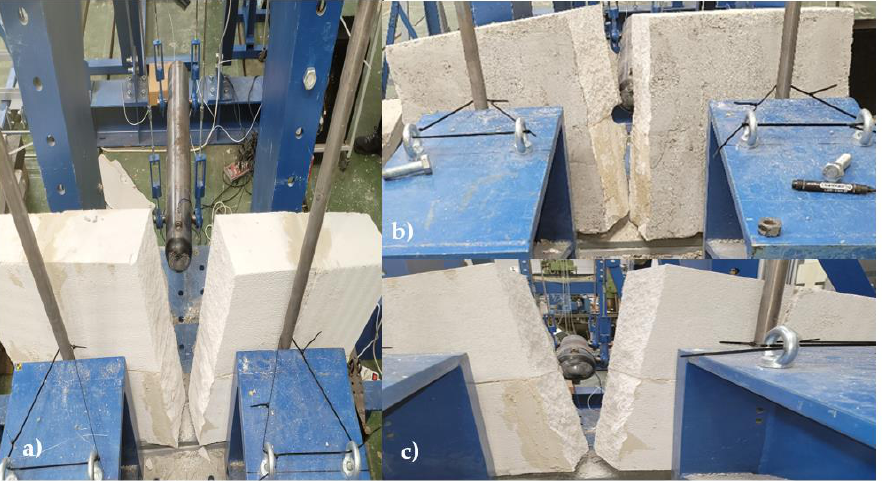
Figure 6. Broken blocks into two parts—( a ) gradual increase method, ( b ) maximum height method, ( c ) constant height method.